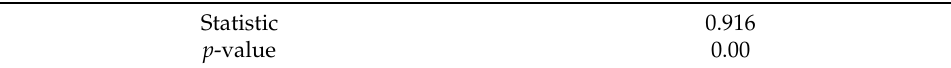
Table 1. Results of the Kolmogorov–Smirnov